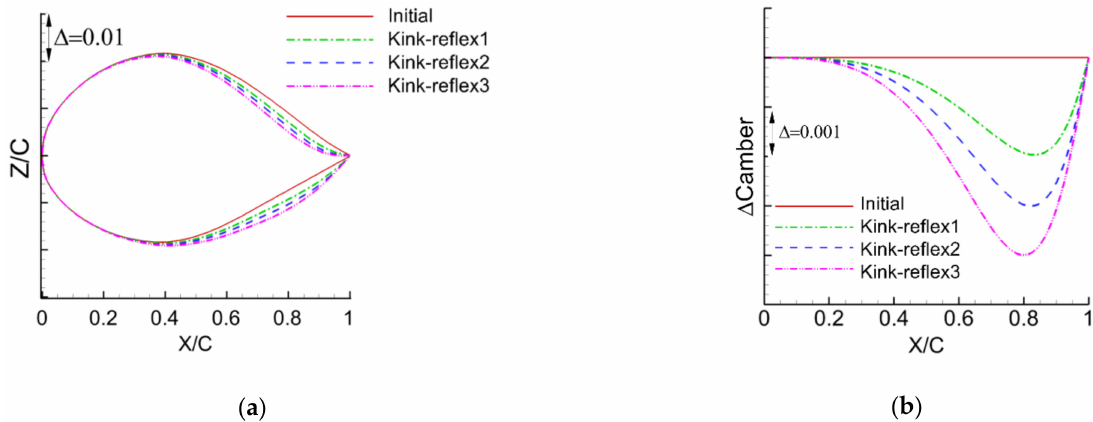
Figure 20. The aft-reflexing modification of kink airfoil. ( a ) Airfoils comparison; ( b ) Different camber increments.